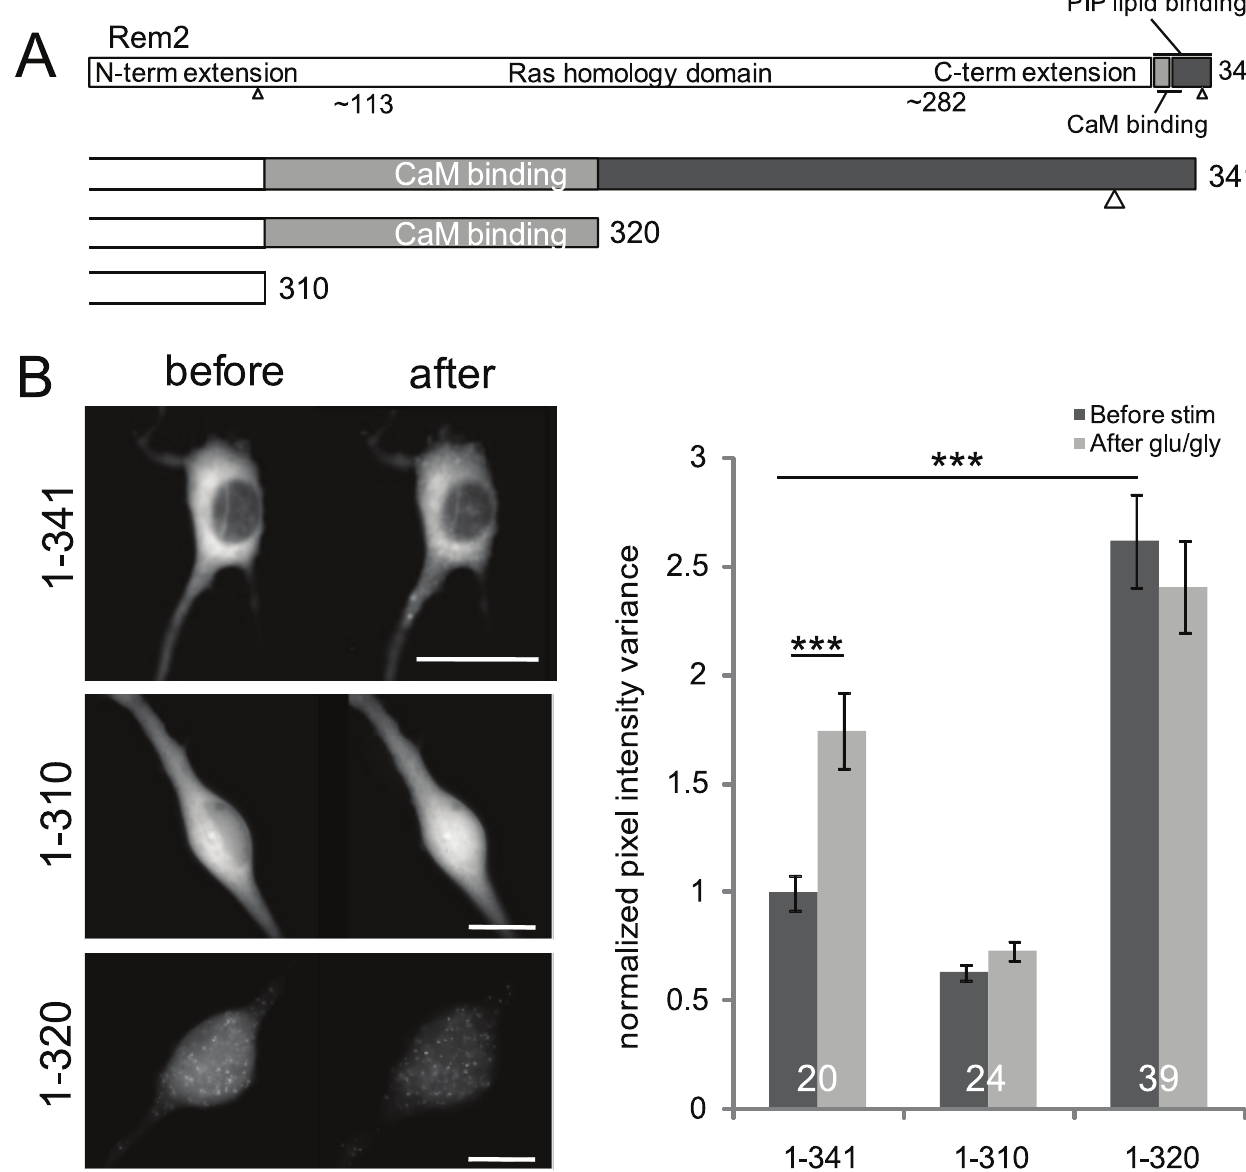
Figure 3. The Rem2 C-terminus directs redistribution. ( A ) Schematic of the Rem2 protein. The last 30 residues of the C-terminal extension contain a previously identified PIP lipid binding domain as well as a calmodulin binding site. Small triangles in the N-and C-termini represent 14-3-3 binding sites. We created truncated Rem2 proteins ending at residues 310 and 320 to determine if these interaction sites are relevant for Rem2 redistribution. ( B ) Effect of Rem2 truncations on redistribution. ( Left panel ) Full-length Rem2 (top) redistributed into puncta on glutamate/glycine stimulation. 1–310 Rem2 (center) showed no redistribution upon stimulation, while 1–320 Rem2 (bottom) formed puncta constitutively. Scale bars indicate 5 m m. ( Right panel ) WT Rem2 shows a significant difference in pixel intensity variance after stimulation (normalized mean ( 6 SEM) pixel value variance before stimulation, 1.00 6 0,08; after, 1.74 6 0.17; paired t-test p , 0.001). Additionally, 1–320 Rem2 distribution is different from WT before but not after stimulation (one-way ANOVA followed by Bonferroni’s test; before, p , 0.001; after, p=0.19). Pixel intensity variances were normalized to the variance of full-length Rem2 before stimulation. doi:10.1371/journal.pone.0041185.g003 To do this, we performed a co-immunoprecipitation assay with Rem2 and CaMKIIN in the presence and absence of Ca 2 + -CaM/ CaMKII. HA-CaMKIIN did not interact with myc-Rem2, and did not interfere with the interaction between myc-Rem2 and GFP-CaMKII (Figure 6D), showing that the effects of CaMKIIN were mediated via CaMKII and not as a result of a direct inhibitory effect on Rem2.